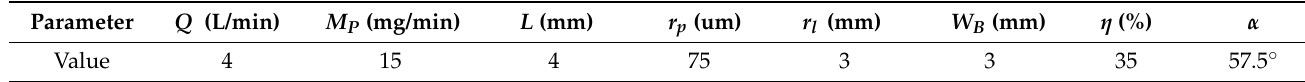
Figure 2. Curve of influence factors of laser energy attenuation rate: ( a ) The powder feeding speed 𝑟 𝑟 𝑀 (cid:3043) , ( b ) The powder particle diameter (cid:3043) , ( c ) Nozzle exit radius (cid:3039) , ( d ) Powder nozzle-to-center dis- tance 𝐿 , ( e ) The angle between the x -axis and the nozzle center α . Table 2. The selection of each parameter of the numerical analysis. Table 2. The selection of each parameter of the numerical analysis.